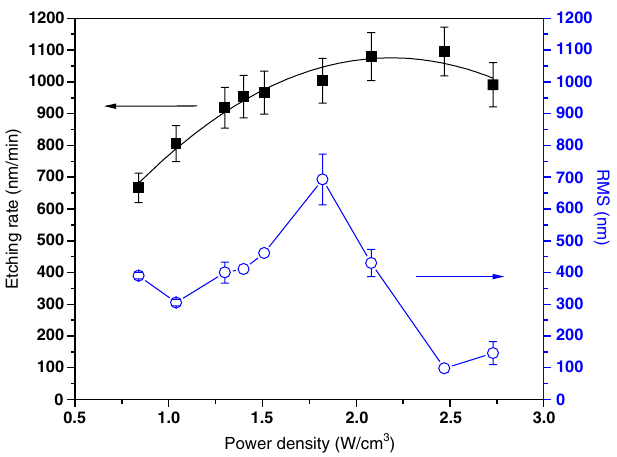
FIG. 3. Etching rate and surface RMS dependence on total gas pressure. Experimental conditions: 3% of Cl 2 in reactive gas mixture, total gas flow 196 sccm, and input power density of 1 : 40 W = cm 3 .